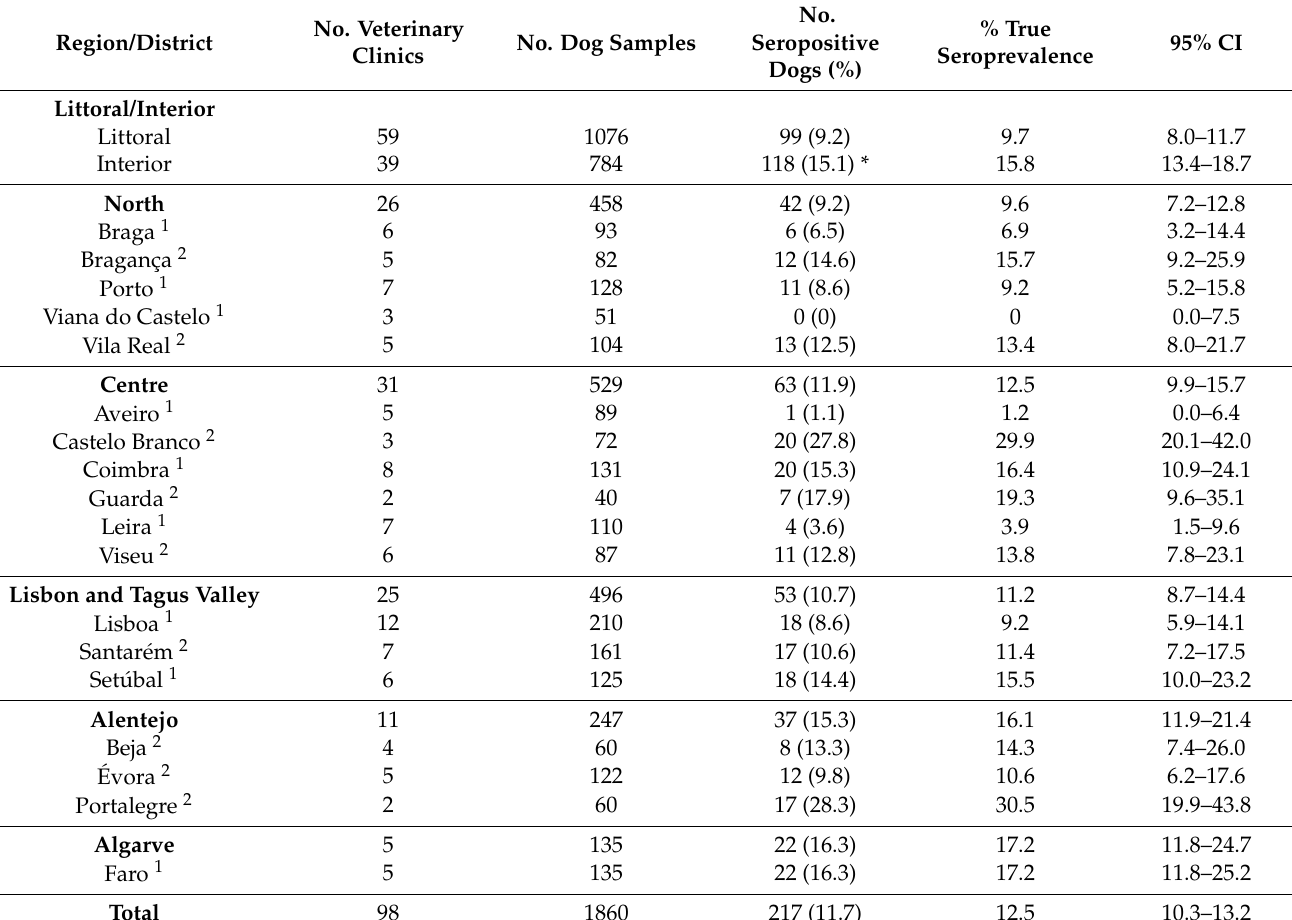
Table 1. Number of enrolled veterinary clinics, and seroprevalence by region (NUTS2) / district of the whole sample